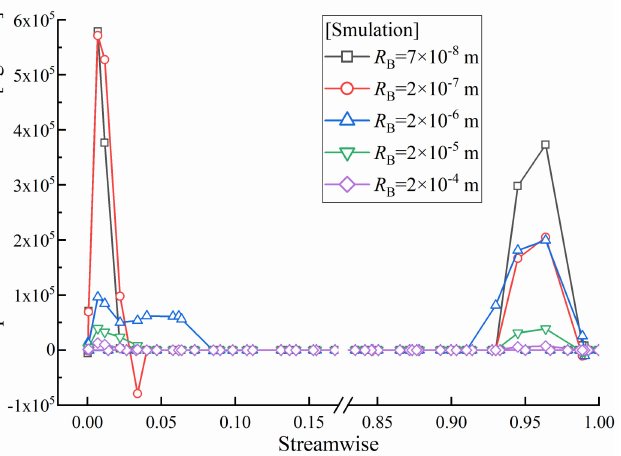
Figure 27. The oilvapor volume fraction on stator blade at stall under various mean radius.